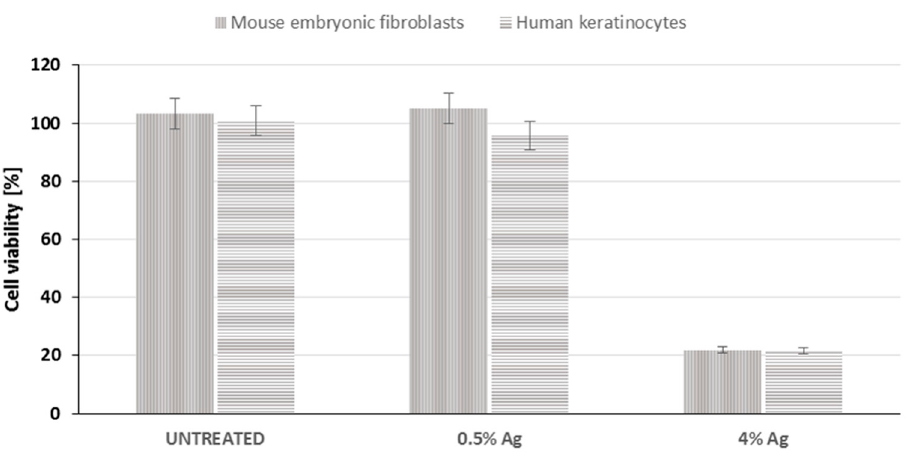
Figure 7. MTT assay for cytotoxicity evaluation.